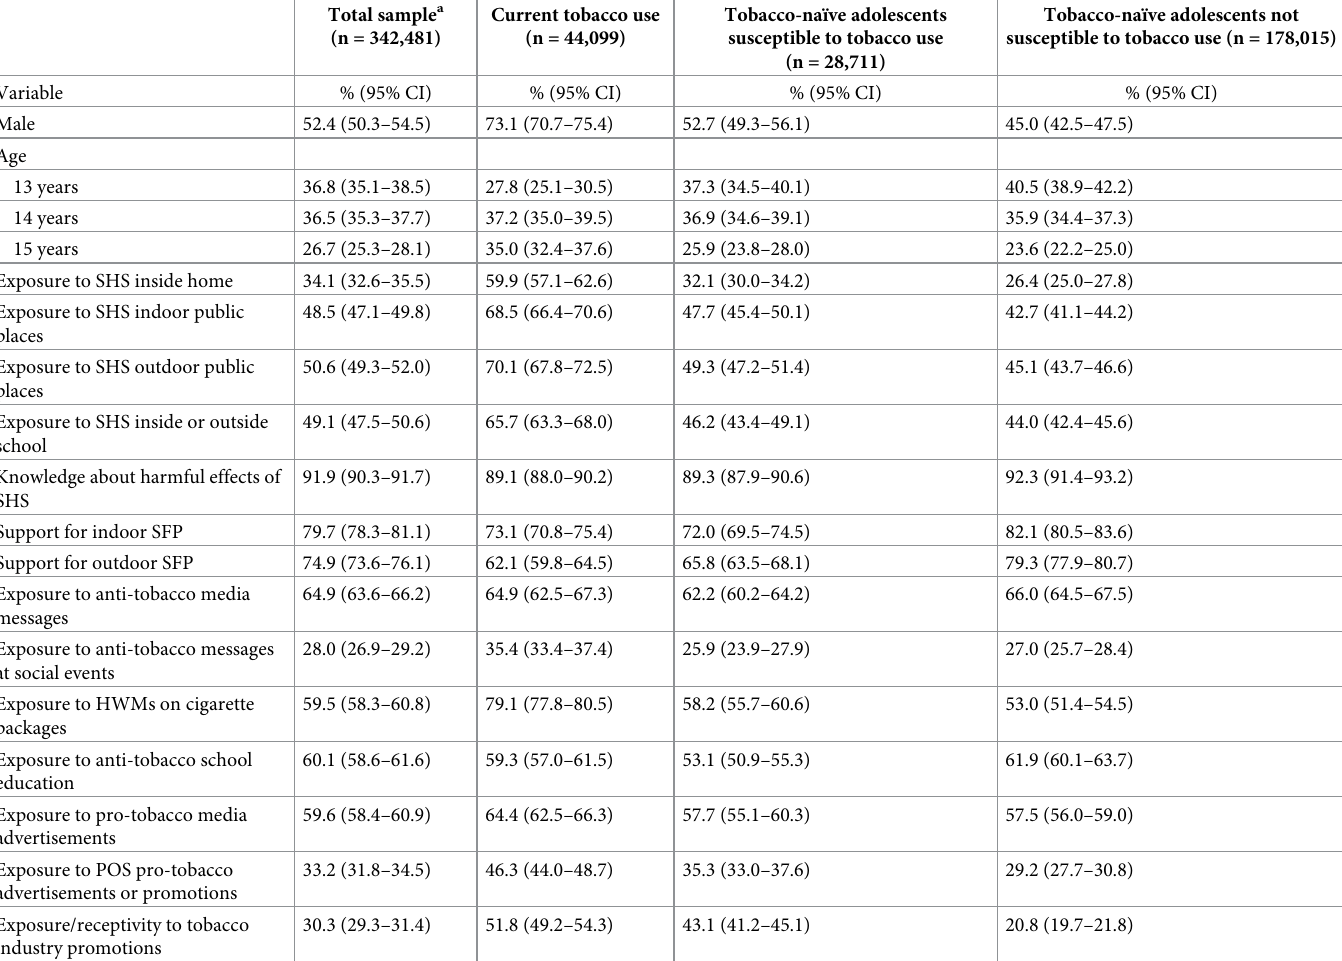
Table 2. Sample characteristics of the full sample adolescents aged 13–15 years from 97 countries in the Global Youth Tobacco Survey, 2013–2017, and of those who currently use tobacco, tobacco-na ï ve adolescents who were susceptible to tobacco use, and tobacco-na ï ve adolescents who were not susceptible to tobacco